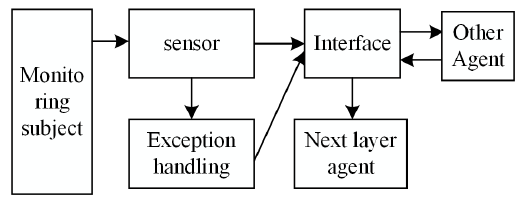
Figure 3. A structural diagram of an SA.